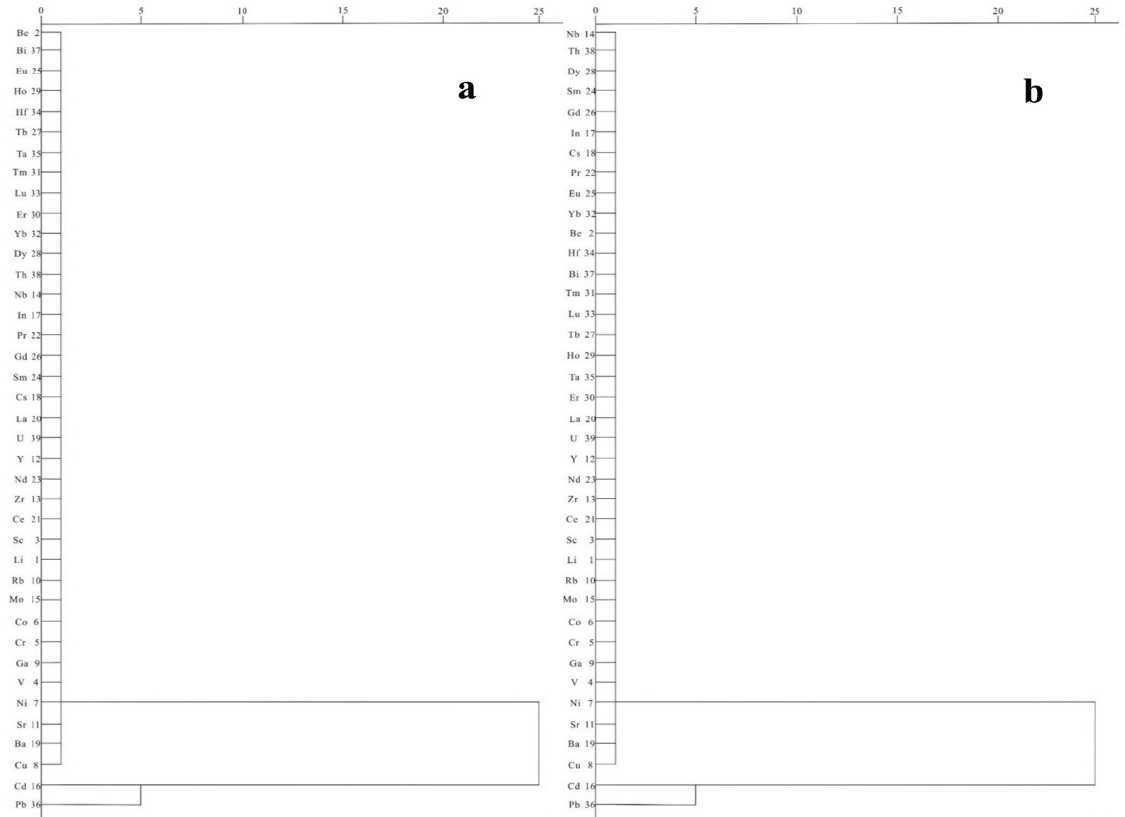
Table 5. Comparison element content changes in samples C and C 1 (ppm).